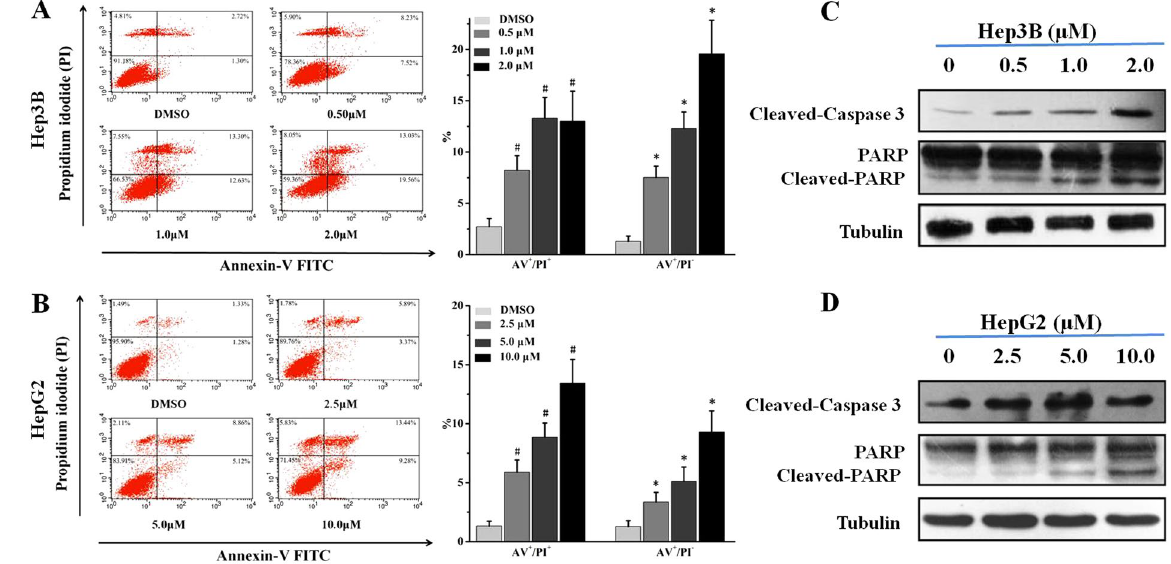
Figure 4. The effects of daphnegiravone D on apoptosis and the expressions of apoptosis-related proteins in Hep3B and HepG2 cells. ( A , B ) Cells were cultured with different concentrations of daphnegiravone D (0.5– 2.0 μ M for Hep3B and 2.5–10.0 μ M for HepG2 cells) respectively for 48 h. After treatment, cells were enriched and performed with Annexin V-FITC/PI staining and analyzed by flow cytometry. ( C , D ) The expressions of cleaved-caspase 3 and -PARP in both hepatoma cells were assessed by Western blot after daphnegiravone D treated 48 h. Tubulin was used as a loading control. The statistical data were expressed as mean ± SD for three independent experiments. # p < 0.05, * p < 0.05 compared with control group.